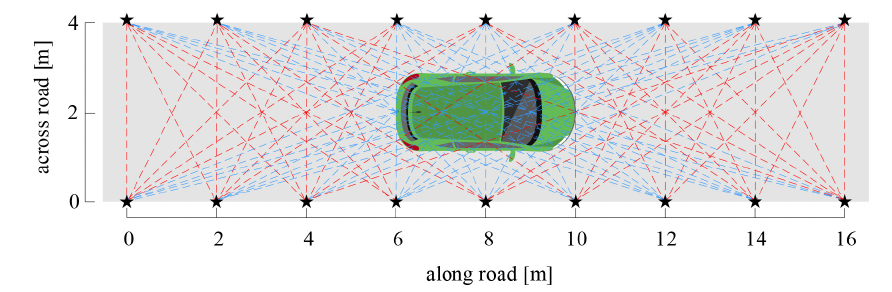
Figure 6. The projection of the 3D links in the X-O-Y plane. The red dashed lines denote the unobscured links; the light-blue dashed lines are the obscured